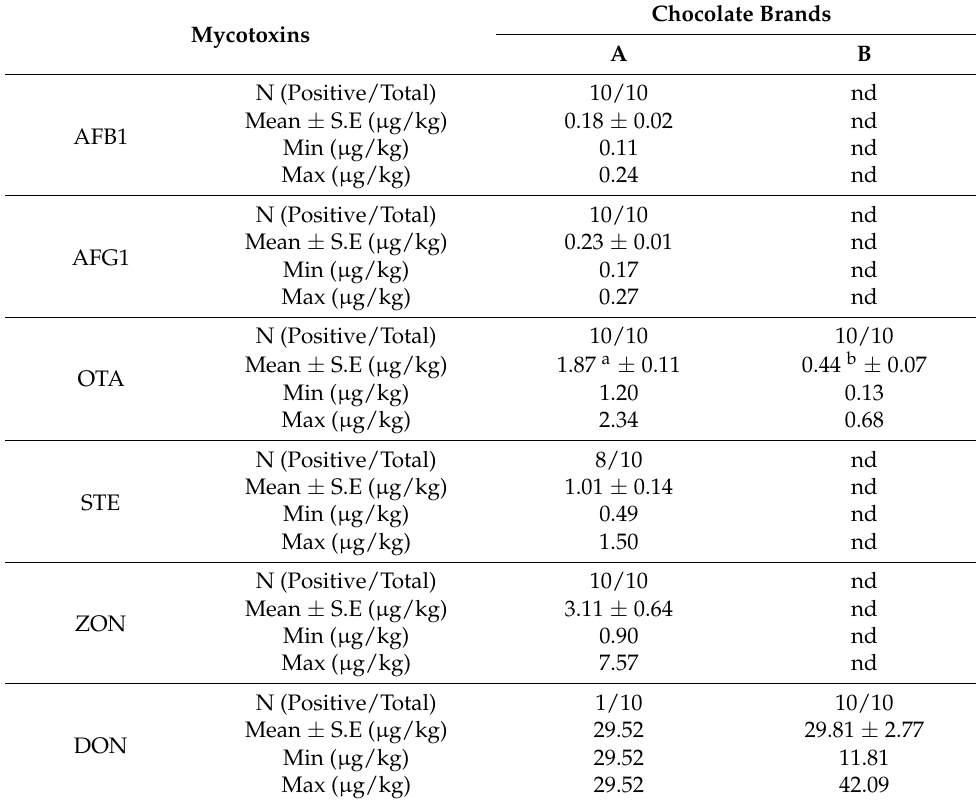
Table 1. Mycotoxin mean ± S.E, as well as the min and max data of positive chocolate samples. Mycotoxins